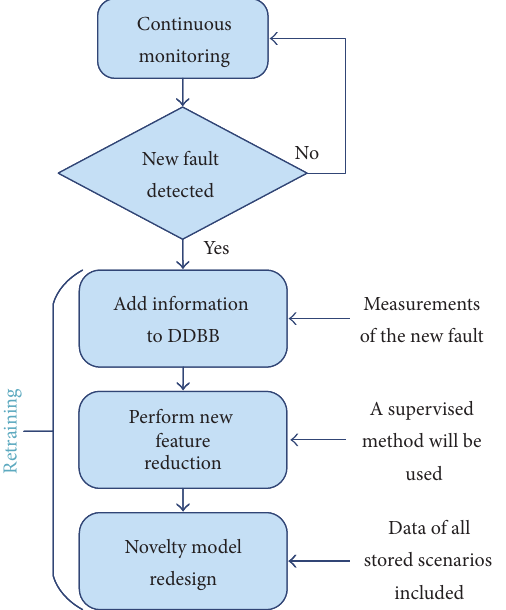
Figure 2: Proposed retraining approach. First, measurements char- acterizingthefaultarestored,andthenthefeaturereductionmodule and the novelty design module are modified to incorporate the new scenario encountered.